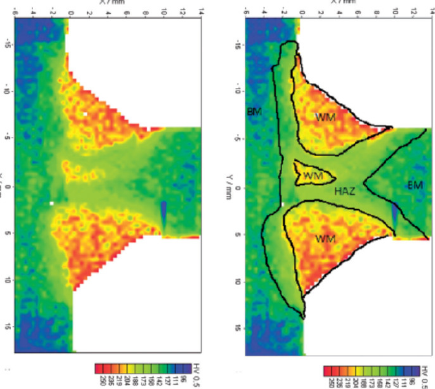
Figure 7. Hardness measurement results and identification of the three zones (WM, HAZ, BM) [13].